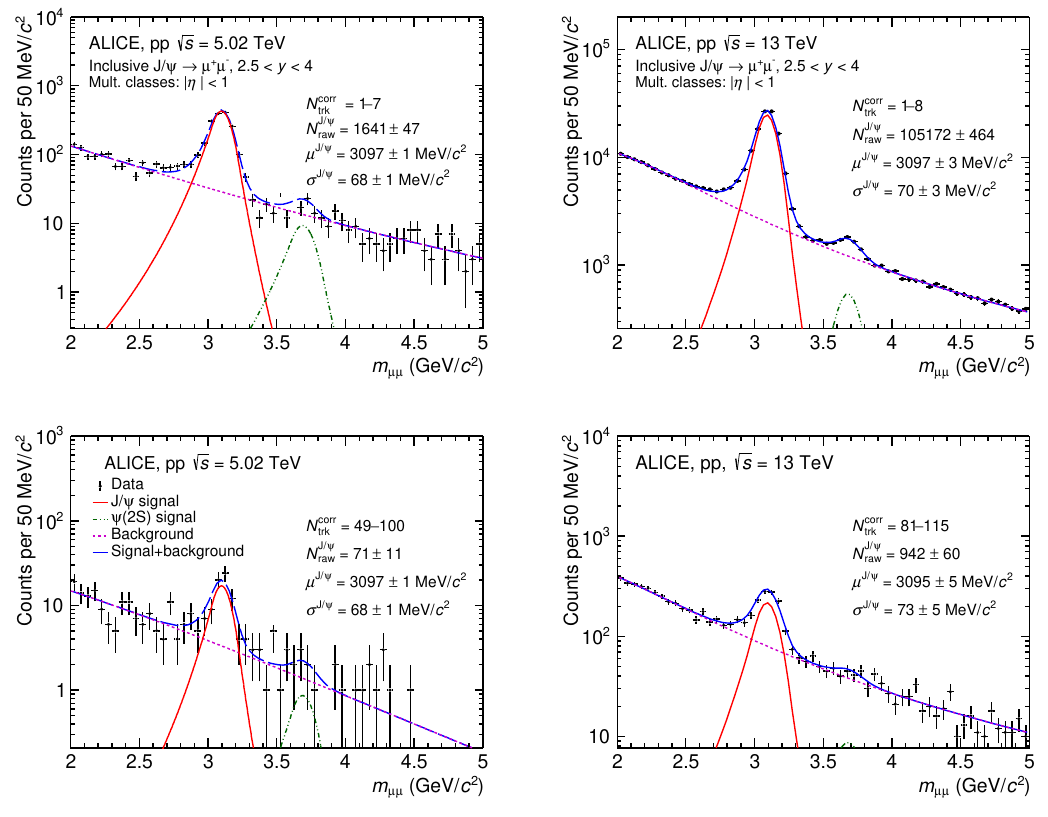
Figure 1 . Dimuon invariant mass distribution in the lowest (top panels) and highest (bottom √ √ panels) N corr intervals in pp collisions at s = 5.02 (left) and s = 13 TeV (right). Example fit trk functions are shown by lines for J /ψ , ψ (2S) signal, background and the combination of signal with background. The data points with error bars are represented by scattered